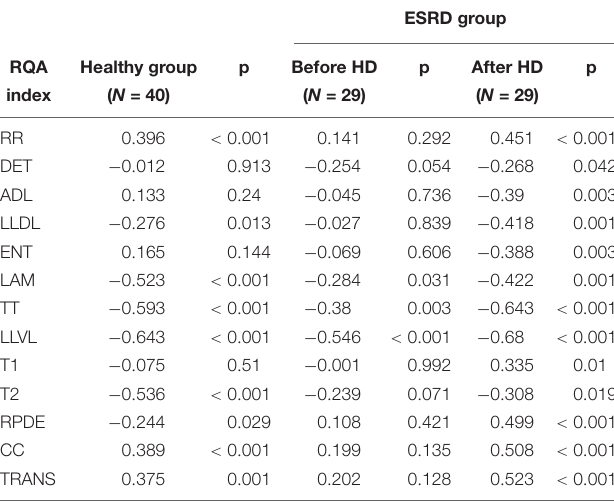
TABLE 4 | Spearman correlation coefficients between meanNN and recurrence quantitative analysis (RQA) indices for the original heart rate variability (HRV) time series.